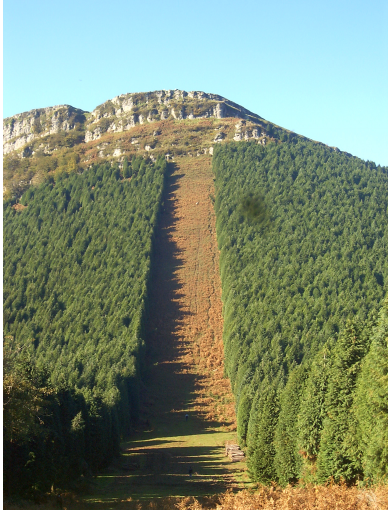
Figure 6. An example of a firebreak (see